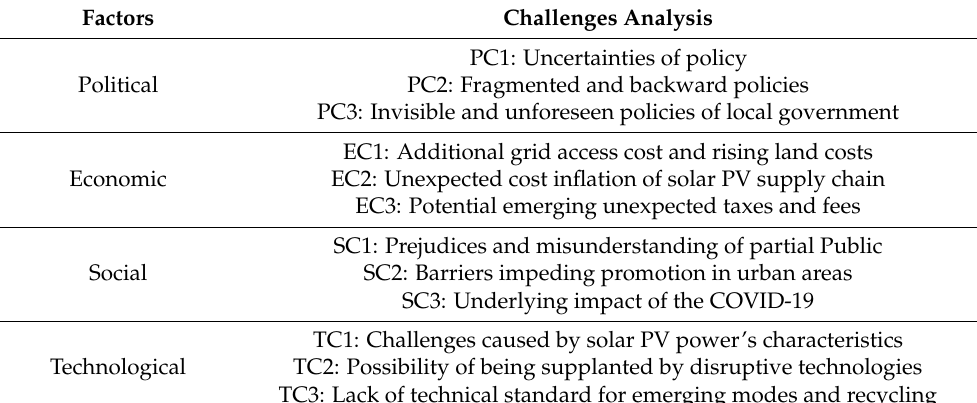
Table 4. The challenges matrix of PEST for further development of solar PV power in